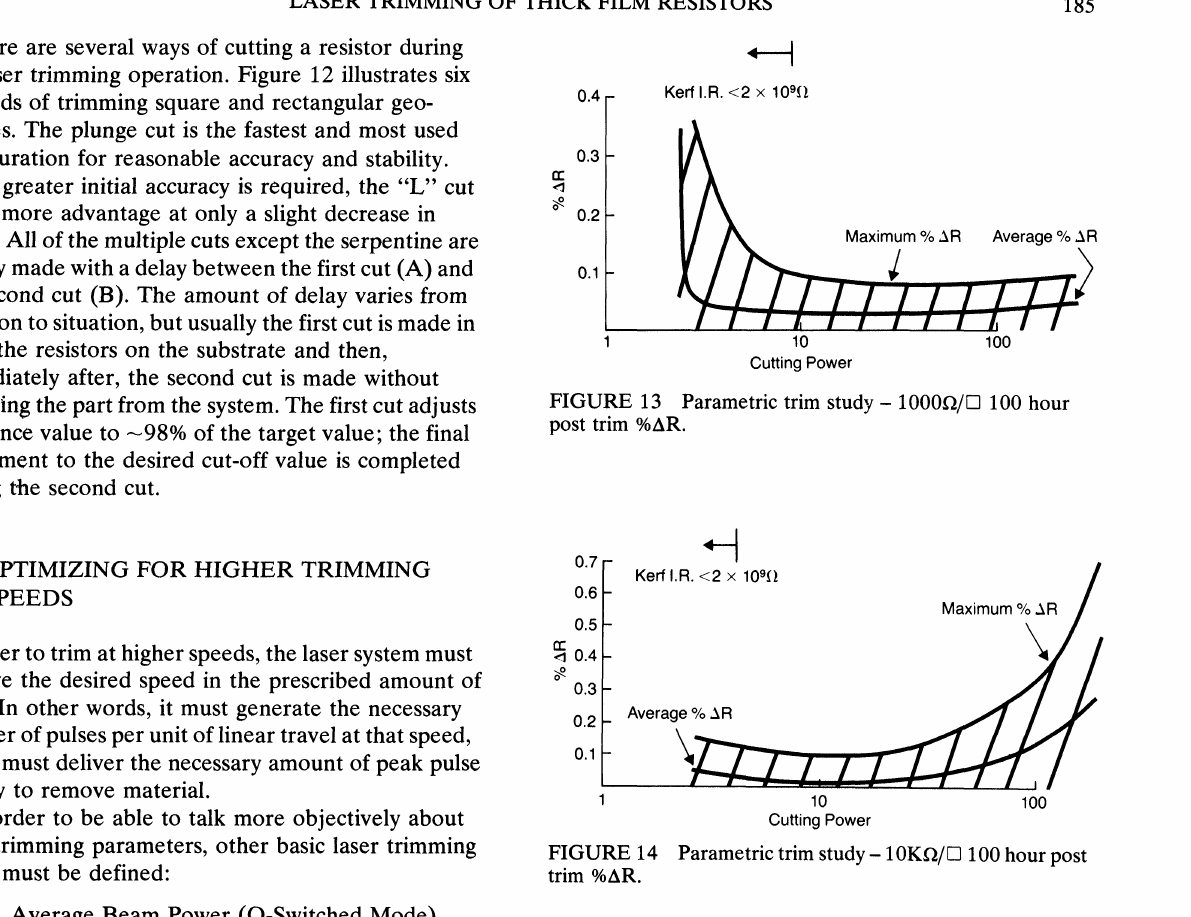
FIGURE 14 Parametric trim study 10Kf/E] 100 hour post trim